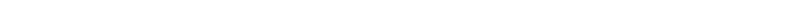
Table 1. Definitions for various terms used in the text.